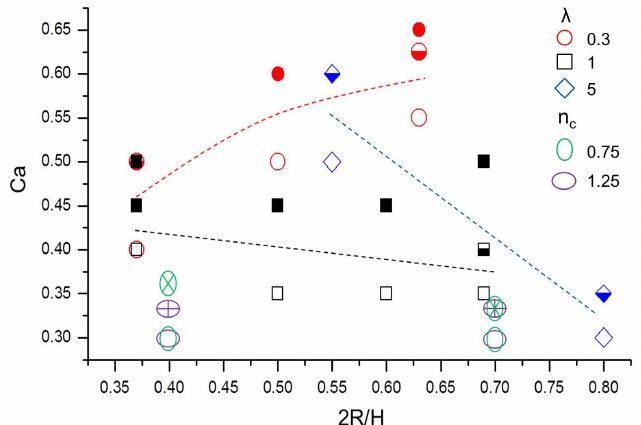
Figure 4. The effect of capillary numbers and confinement ratio on the droplet steady deformation or breakup for the case of a Newtonian droplet in Newtonian matrix fluids ( λ = 0.3,1,5 and n c = 1), and in power–law matrix fluids ( n c = 0.75,1.25 and λ PL = 1). The open symbols depict steady states. The half-filled symbols depict binary breakup, and the full symbols ternary breakup for the Newtonian cases, while the crossed symbols show binary breakup for droplets in power–law matrix fluid. The lines highlight the critical capillary numbers for the case of the Newtonian